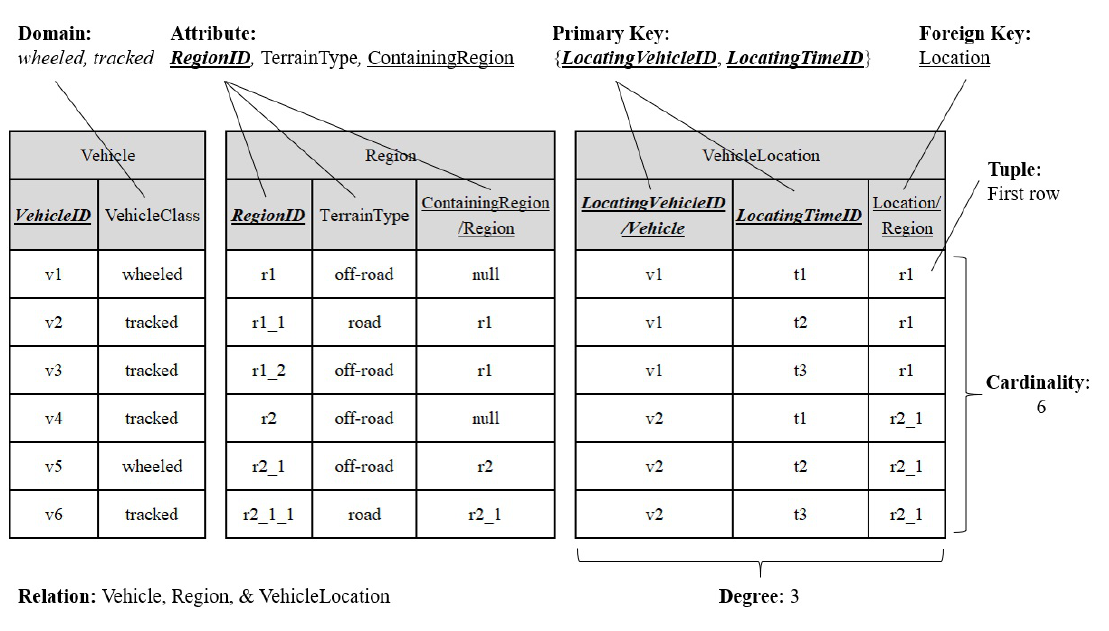
Figure 2. Example of a Part of the Vehicle Identification